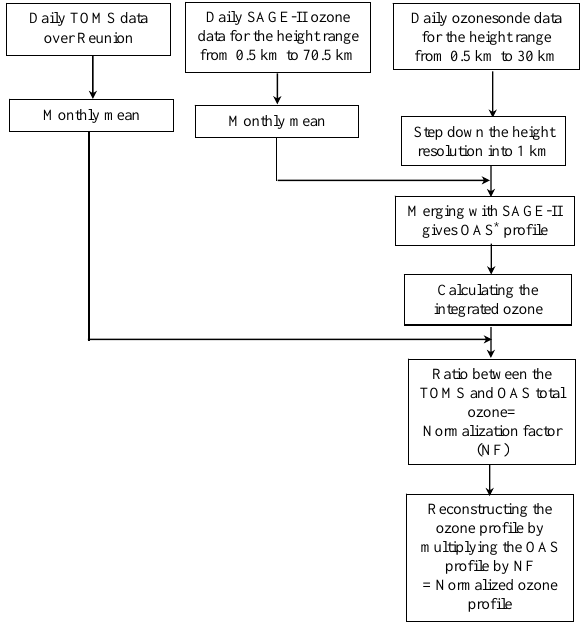
FIGURE-2: Fig. 2. Flow diagram represents the procedure followed to ob- Flow diagram represents the procedure followed to obtain the normalized ozone profile. tain the normalized ozon profile. OAS refers to the combined * OAS refers to the combined ozonesonde and SAGE-II profile. ozonesonde and SAGE-II